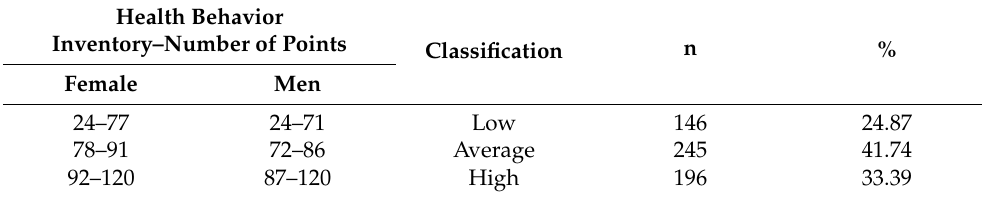
Table 2. Level of Health Behavior Inventory among nurses (n =